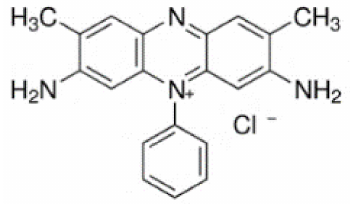
Figure 1. Chemical structure of the SO